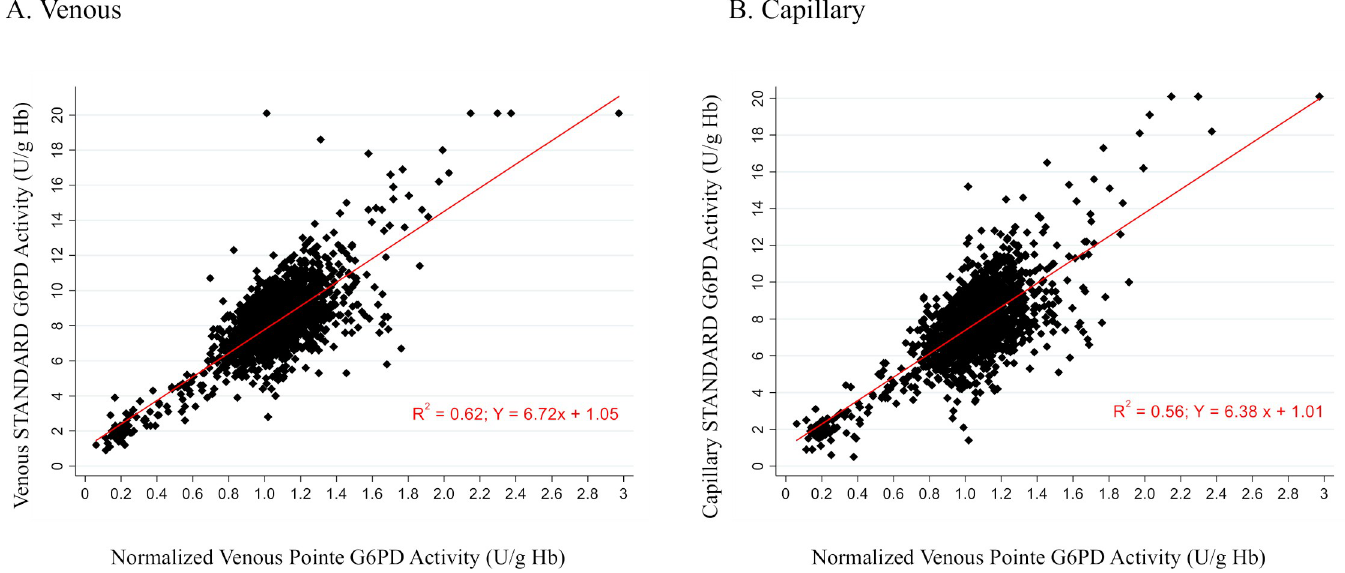
Fig 3. Regression analysis of STANDARD G6PD Test’s G6PD activity on A) venous specimens and B) capillary specimens, compared to normalized spectrophotometric reference test on venous specimens.